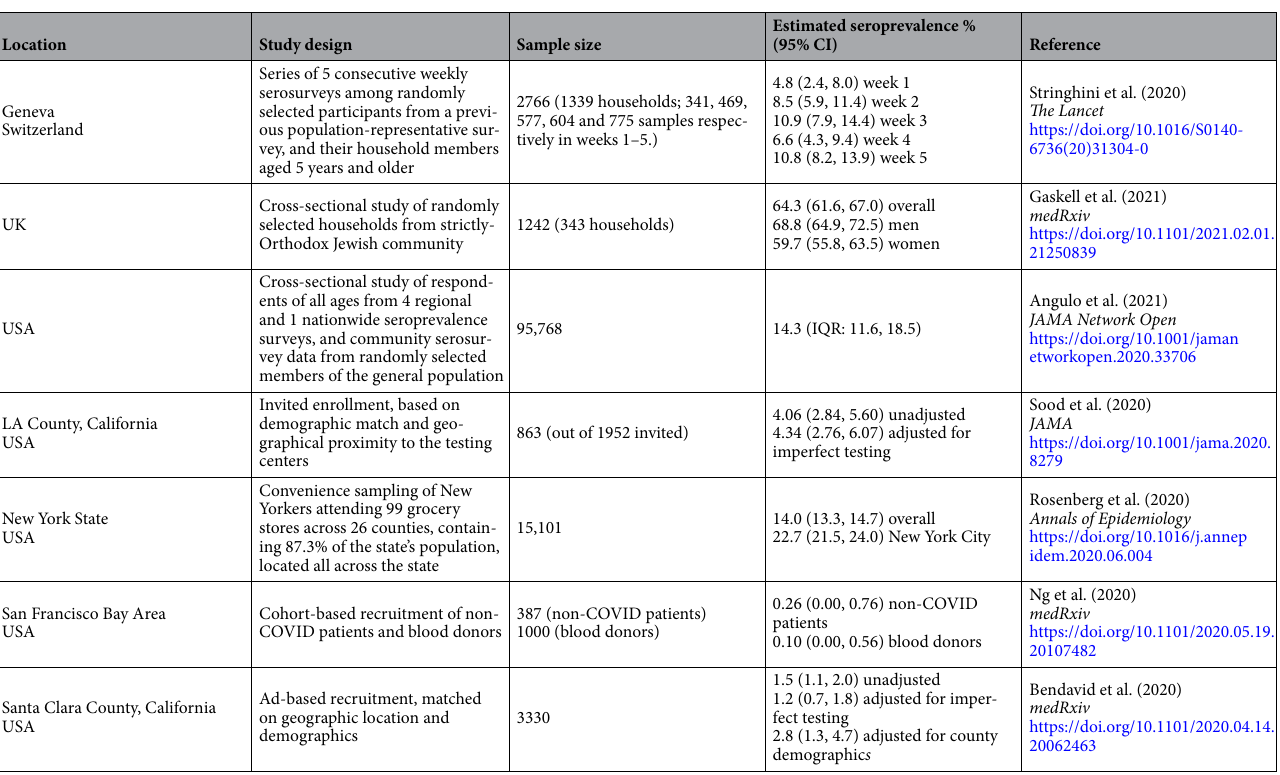
Table 1. Summary of COVID-19 seroprevalence studies across the